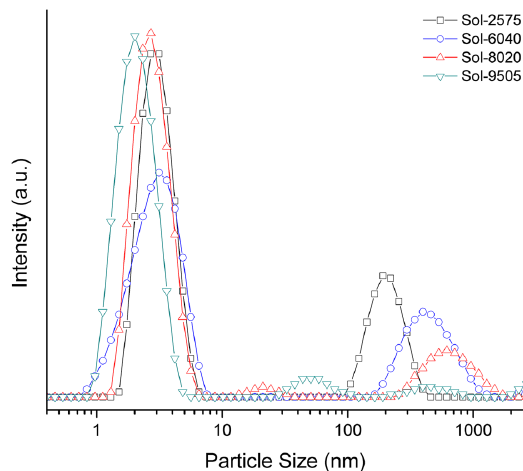
Figure 4. Size distribution curves as recorded by dynamic light scattering for samples aged for 10 days after synthesis.